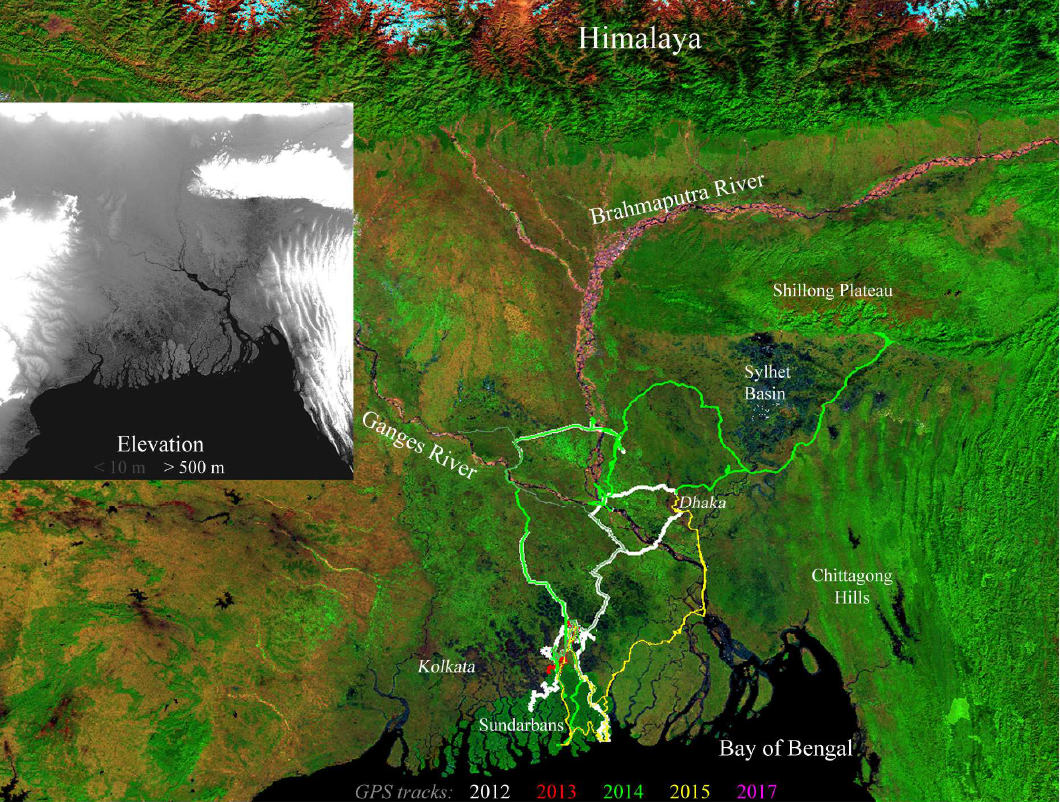
Figure 1. Index maps of the Ganges-Brahmaputra Delta (top) and Sundarban mangrove forest (bottom). Elevation map (inset) superimposed on MODIS composite shows height gradient of the forest canopy and subsidence of the polders north of the Sundarban. Sentinel 2 False color composite (bottom) shows current river channel network and forest canopy cover variations. Note contrast between post-monsoon rice(top) and winter fallow (bottom) in agricultural areas surrounding the